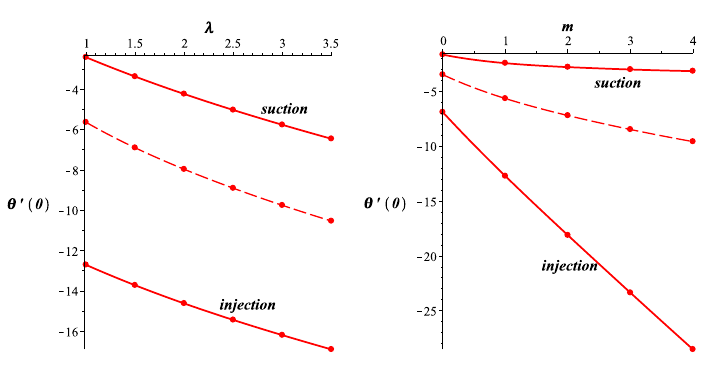
Figure 11. Effect of power-law exponent m on the heat transfer